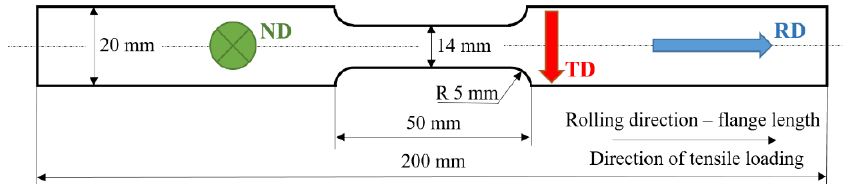
Figure 1. Shape and dimensions of the sample employed for the uniaxial tensile test.